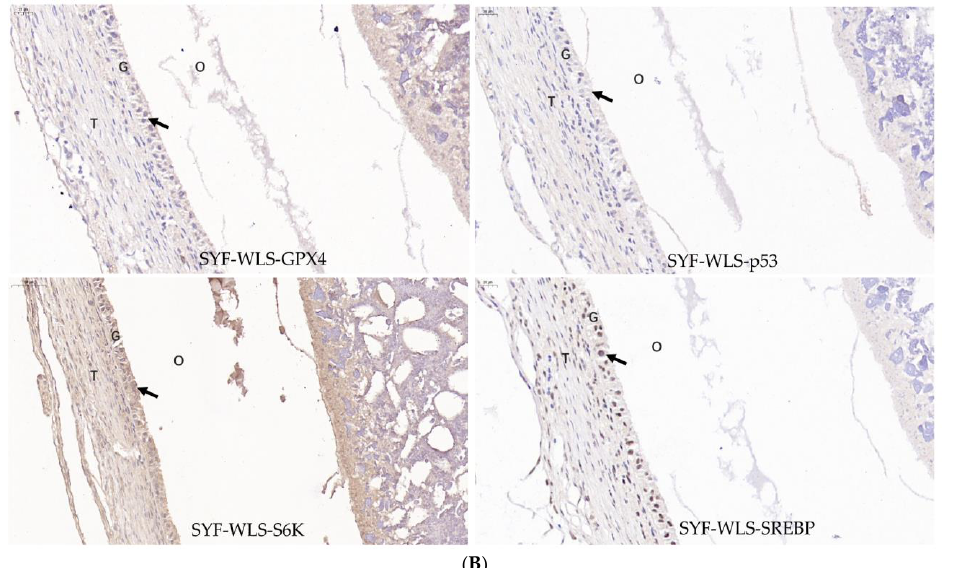
Figure 7. ( A ) Expression levels of genes associated with oxidative stress in chicken SYF tissue. SYF-WLS-150 represents small yellow follicles of Wu Liang Shan at 150 days. SYF-CH-150 represents small yellow follicles of Cha Hua No. 2. at 150 days. * p < 0.05, indicating significance compared to the WLS group. *** p <0.001 indicating extreme significance compared to the WLS group. ( B ) Expression pattern of protein associated with oxidative stress in chicken SYF tissue (400× magnification) expressed in the granulosa cell layer of SYF. Arrows point to the GC layer of SYF.